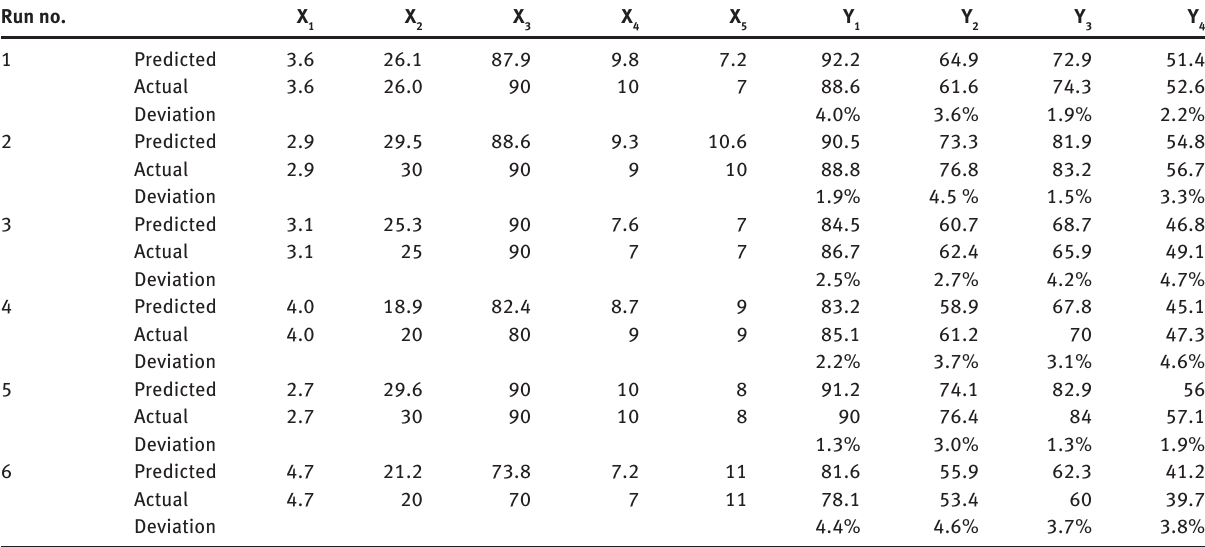
Table 3 Validation test results. Run